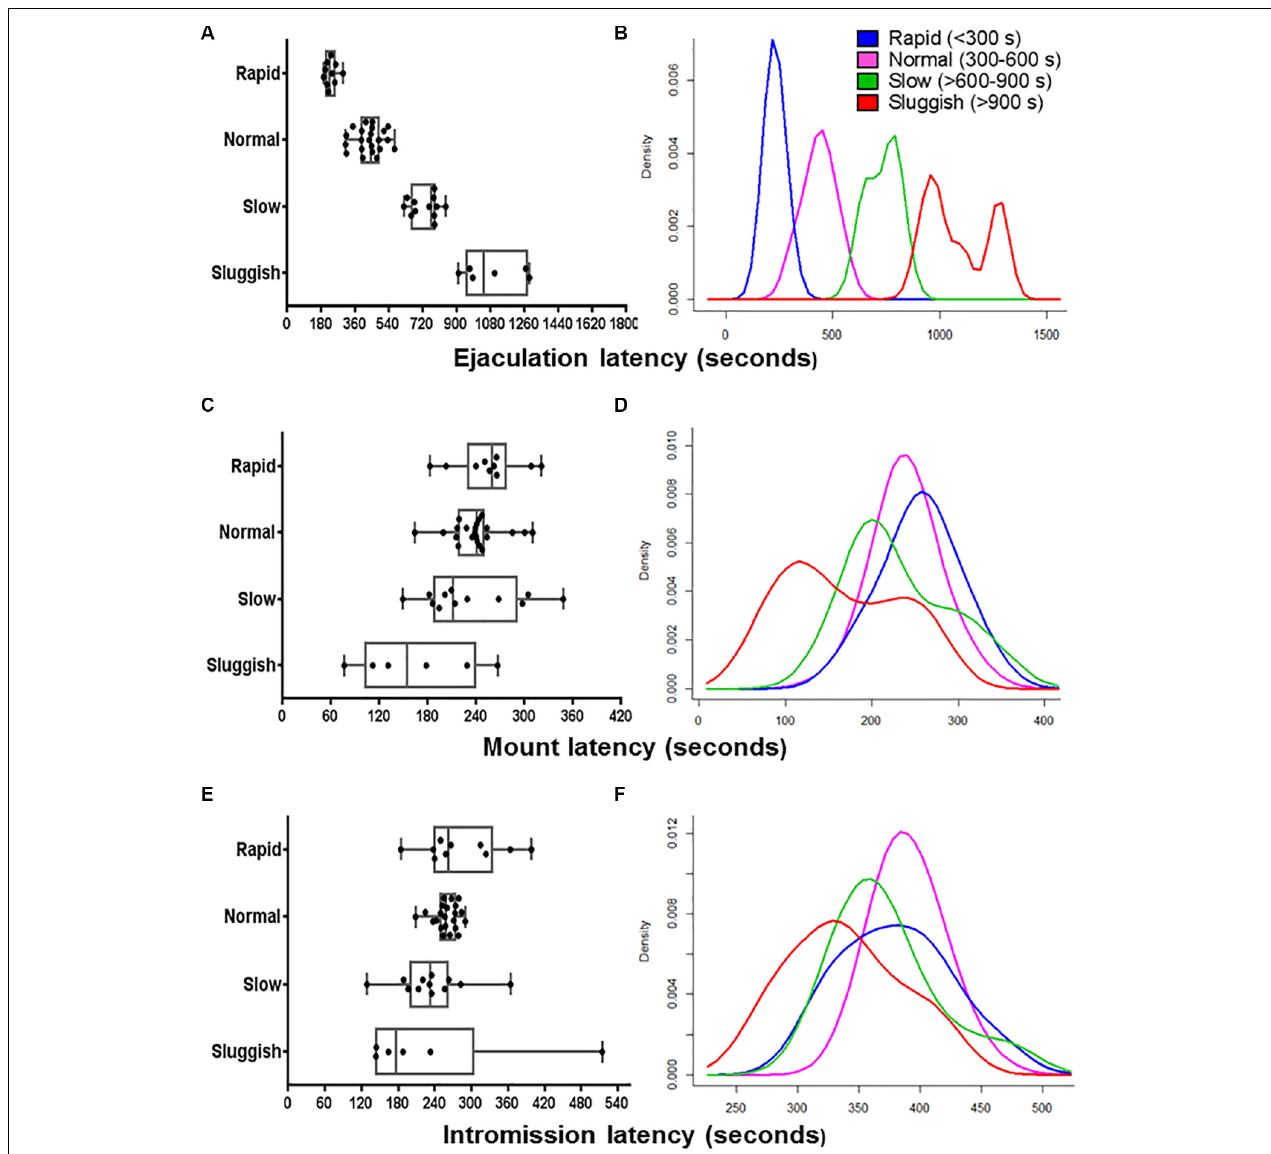
FIGURE 1 | The internal consistency of the presumed EL-ejaculatory endophenotypes is compromised by introducing any other copulatory parameter in addition to EL as phenotyping variate. Boxplots (A,C,E) and probability density plots (B,D,F) allowed us to evaluate the internal consistency of the presumed EL-ejaculatory endophenotypes (A,B) after introducing as covariates of phenotyping mount latency (C,D) and intromission latency (E,F) . When EL was used as the exclusive phenotyping variate, a clear-cut segregation with virtually no overlapping across the presumed EL-ejaculatory endophenotypes was observed (A,B) . In contrast, when EL was paired with mount latency (C,D) and intromission latency (E,F) , a great deal of overlapping occurred among the presumed EL-ejaculatory